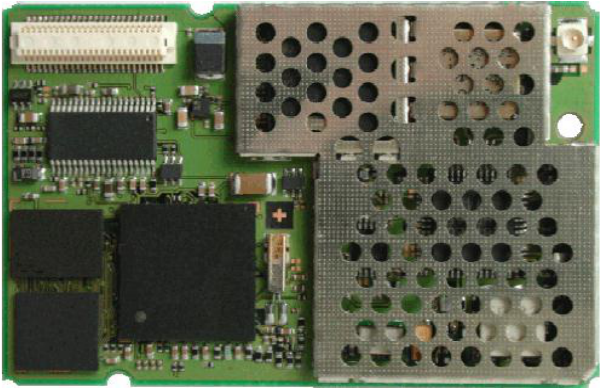
Figure 17. Siemens MC45 GSM